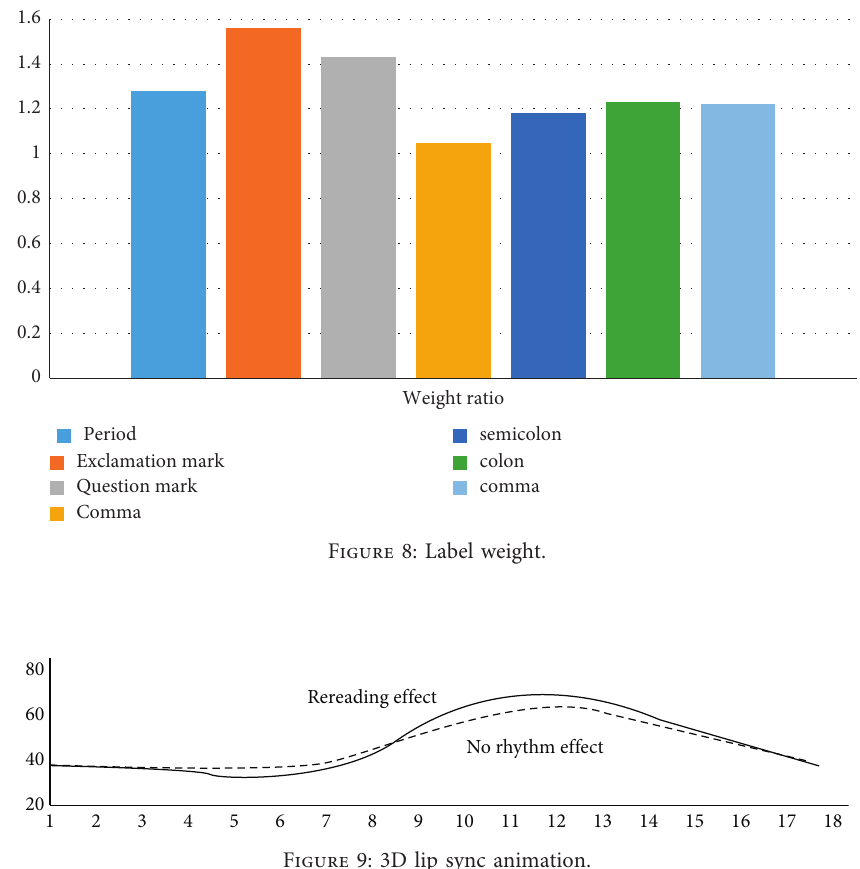
Figure 9: 3D lip sync animation.